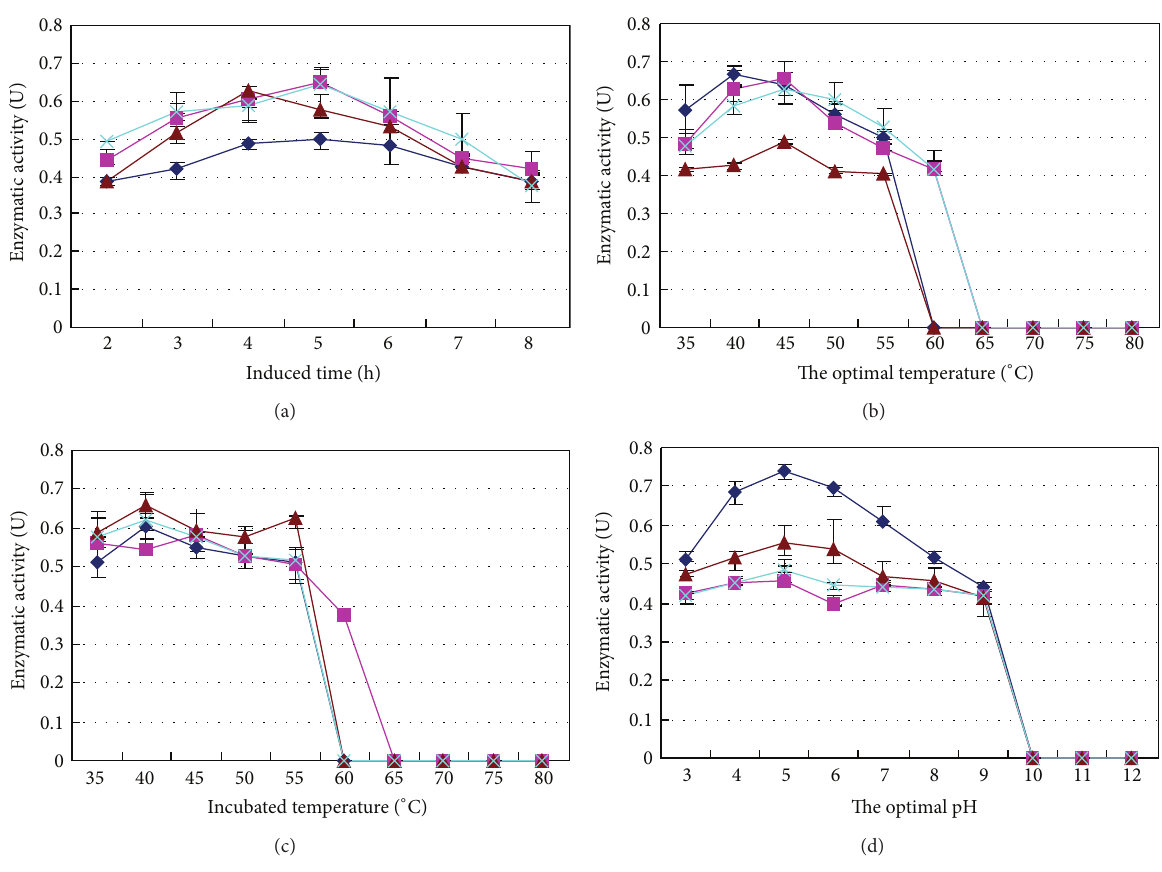
Figure 3: Enzymatic properties of four different recombinant chitinases. Dark blue: enzymatic properties of recombinant intracellular inrCHI31; pink: enzymatic properties of recombinant extracellular exrCHI31; purple: enzymatic properties of recombinant intracellular inrCHI32; Powder blue: enzymatic properties of recombinant intracellular exrCHI32. The precipitates of transformants BL21-inCHI31 and BL21-inCHI32 were used to measure chitinase activity. The culture supernatants of transformants BL21-exCHI31 and BL21-exCHI32 were used to measure chitinase activity. The supernatant was used as a control after being boiled at 100 ∘ C for 20 min. (a) Regulation of enzyme production of four transformants BL21-inCHI31, BL21-exCHI31, BL21-inCHI32, and BL21-exCHI32. The four transformants were induced by 1mM IPTG at 30 ∘ C for 2 to 8h, with 1h intervals. The enzyme activities at different induced times were measured. (b) The effects of temperature on four recombinant activities. The chitinase activities were measured between 35 ∘ C and 80 ∘ C for 30min at 5 ∘ C intervals (pH = 4.5). (c) The effects of temperature on the stability of four recombinases. The enzymatic solution (pH = 4.5) was incubated between 35 ∘ C and 80 ∘ C for 30 min at 5 ∘ C intervals, and the remaining activity was then measured. (d) The effects of pH on four recombinase enzymatic activities. Enzymatic activity was measured in the reaction buffer at different pH values from 3 to 12 at 1-unit intervals. All experiments were performed three